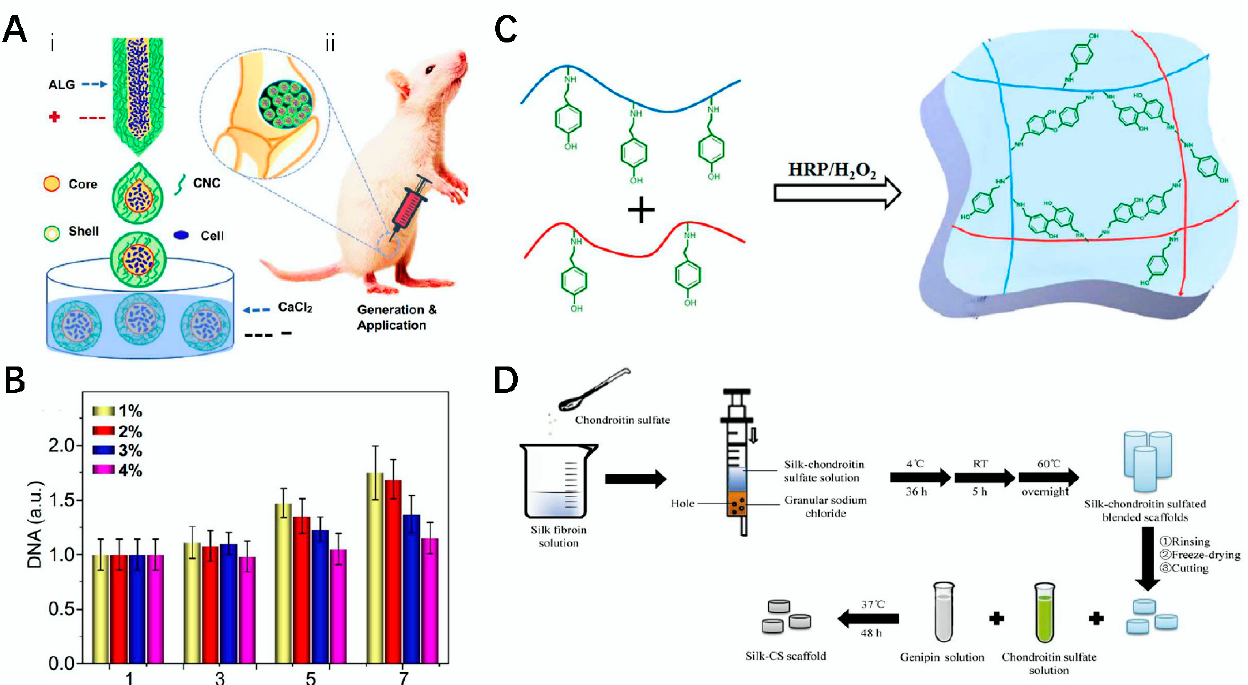
Figure 8. Route map and application of polysaccharide processed into composite materials. ( A ) preparation of core–shell microcapsules and its application in rats [117]. ( B ) effects of microcapsules at different concentrations on cell proliferation [117]. ( C ) schematic diagram of CA-TA and CMP-TA cross-linking gel formation [118]. ( D ) schematic diagram of silk-CS scaffold preparation [119].